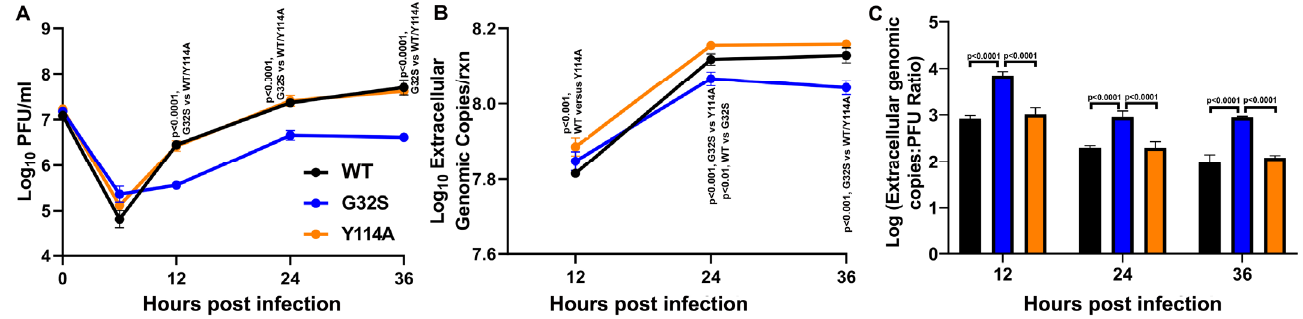
Figure 6. Infectivity of virions released from C8-D1A cells infected with CHIKV WT, G32S, and Y114A. C8-D1A cells were infected with CHIKV WT and nsP3 MD mutants G32S and Y114A at an MOI 5 measured by plaque assay on Vero cells. ( A ) Infectious extracellular virus released into the supernatant fluid as measured by plaque formation on Vero cells. ( B ) Genomic viral RNA (gRNA) released into supernatant fluid as quantified by qRT-PCR and displayed as log 10 extracellular genome copies. ( C ) Ratios of genome copies: PFU for extracellular virions as calculated by converting qRT-PCR genomic copy per reaction data to genome copies per milliliter and dividing by PFU/mL at that time point. Values are an average of 3 biological replicates ± SD. p values indicate the significance of differences between G32S and WT or Y114A at each time point.